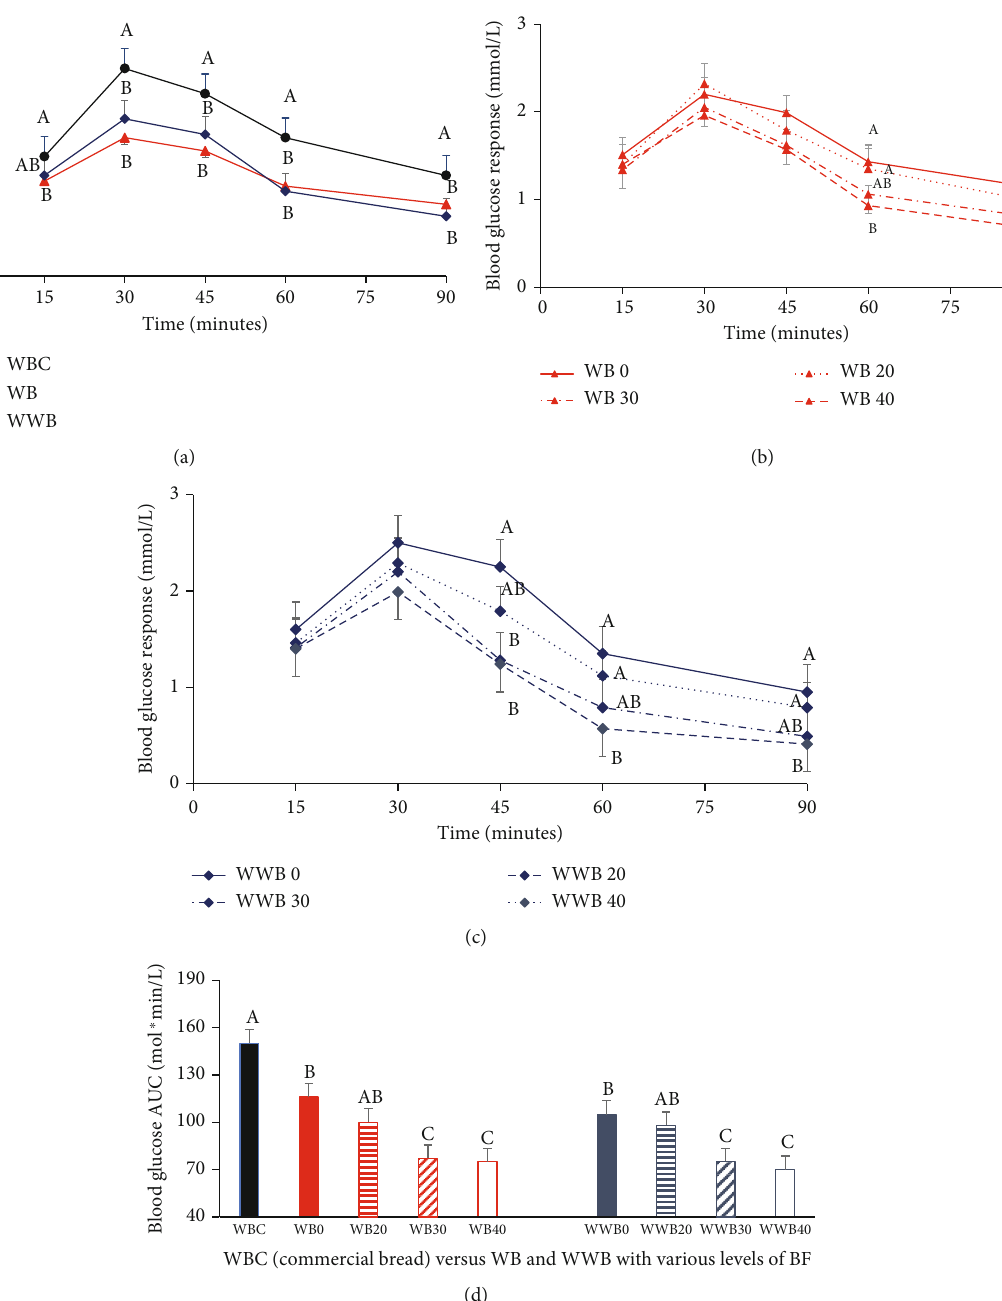
Figure 3: E ff ect of bread consumption on blood glucose concentration over time for 90 minutes in healthy volunteers. (a) Blood glucose concentration response to white bread, whole wheat bread, and wheat bread purchased from the market. (b) Blood glucose concentration in response to chickpea fl our substituted at various ratios to white bread. (c) Blood glucose concentration in response to chickpea fl our substituted at various ratios to whole wheat bread. (d) Blood glucose concentration under the area under the curve (AUC) in response to chickpea fl our substituted at various ratios to white fl our bread and whole wheat bread compared to commercial wheat bread. Data is presented as mean ± SEM ( n = 15 ). (a – c) Values within the same time points are signi fi cant at p < 0 : 05 . (d) Di ff erent superscript letters on the bars represent di ff erences among the breads at p < 0 : 05 . Legends: WBC =wheat bread commercial (from the supermarket); WB =white bread; WWB=whole wheat bread; WB/WWB 0, 20, 30, and 40 refer to chickpea fl our substitution at 0 (control), 20%, 30%, and 40% level to white fl our or whole wheat fl